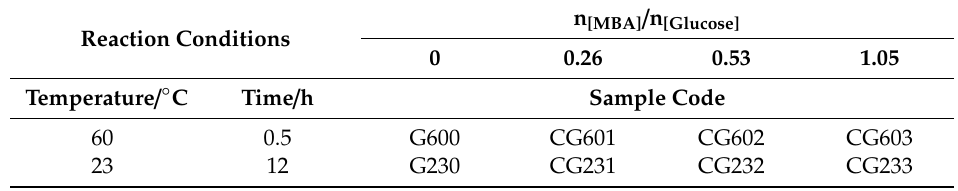
Table 1. Molar ratios of MBA / glucose and sample nomenclature for the di ff erent curing